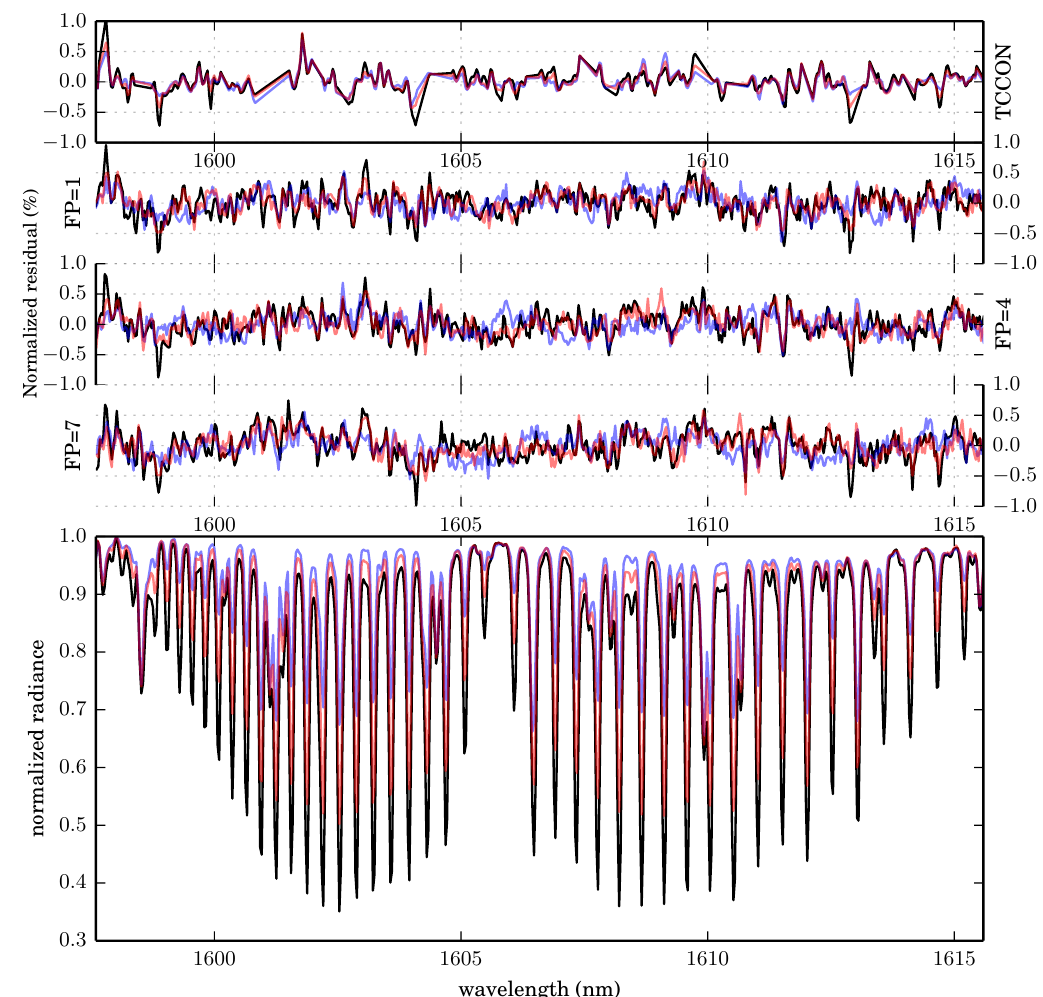
Figure 4. Spectral fits to direct-sun measurements in the WCO2 band of OCO-2 and TCCON (analogous to Fig. 3). cific software setups. Also, convolved spectral residuals of fits to high-resolution (e.g. FTS) data are not equal to resid- uals of fits to convolved spectra. In addition, solar lines were masked out for the FTS fits since, as noted above, the OCO- 200 2 instrument, in TVAC mode, records full-disk solar spec- tra while the FTS records narrow field-of-view disk-centered spectra. In the following, we will display fit residuals in per- cent, normalized by a representative continuum level radi- ance, chosen as the maximum signal within each band. For 205 the comparison, we chose OCO-2 and TCCON spectra where the zero-path difference (ZPD) was within a few seconds of the OCO-2 spectra acquisition. For the sake of clarity, we show residuals from only 3 out of the 8 footprints. However we did verify that all footprints behave similarly. For all tests, 210 we used the ABSorption COefficient (ABSCO) v4.2 spec-